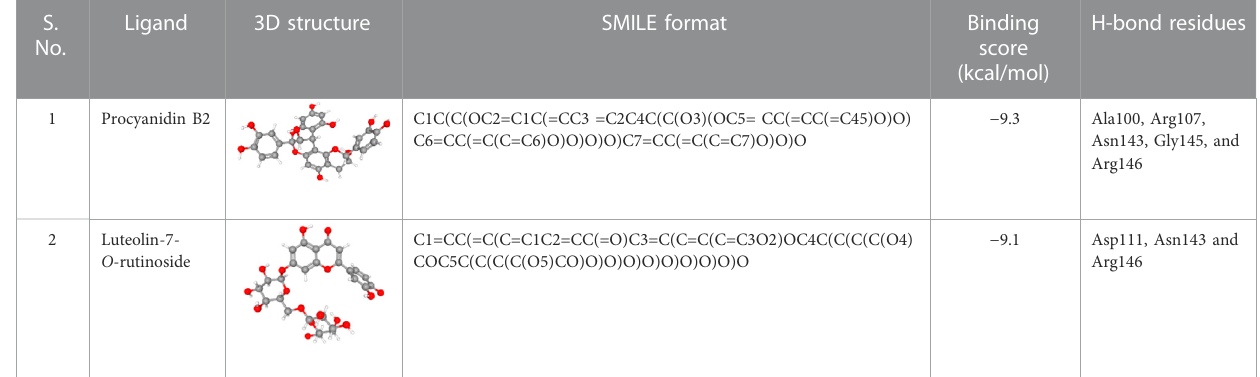
TABLE 2 Ligands name, 3D structures, SMILE format and the virtual screening outputs. S.